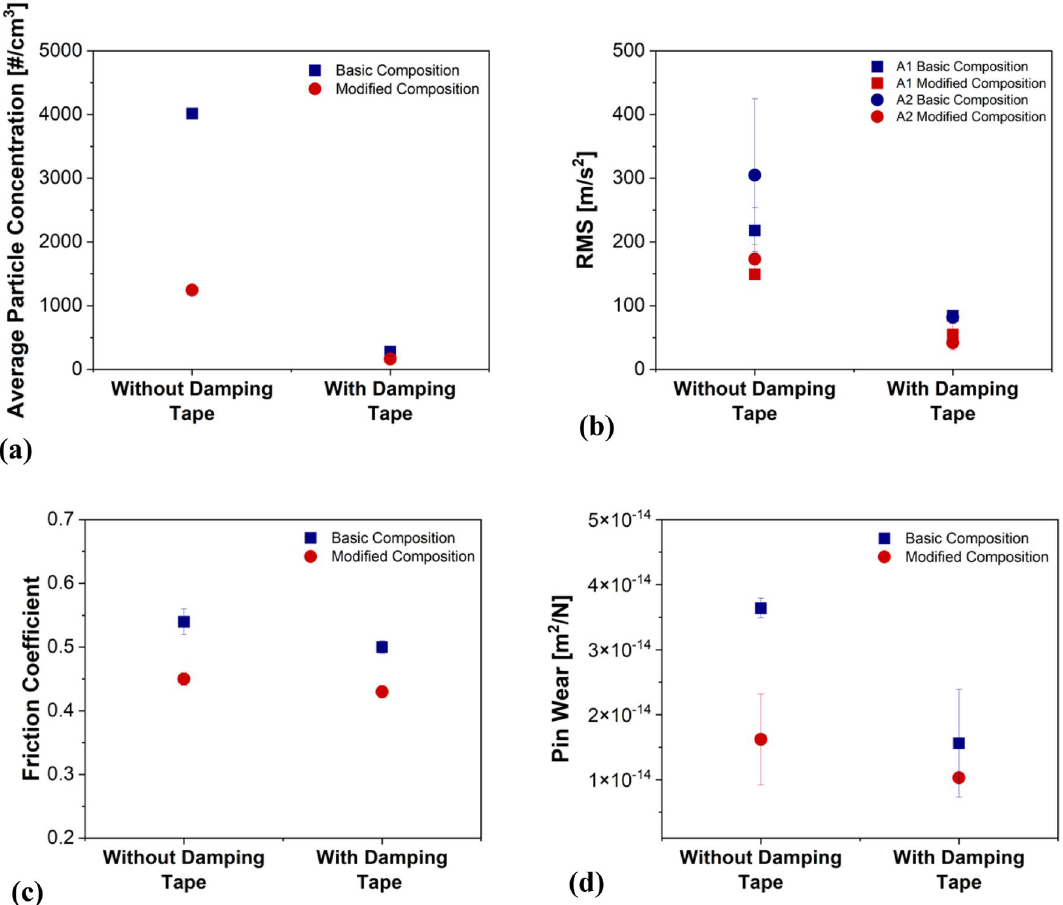
Figure 3. Comparison of ( a ) Emission; ( b ) Vibration (A1 and A2); ( c ) CoF trends; and ( d ) Pin wear with and without damping tape for the BC and MC specimens.